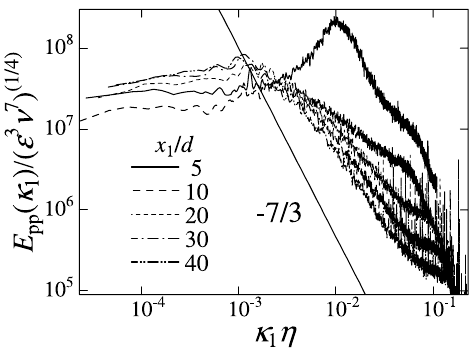
Fig. 16 Power spectra of fluctuating static pressure on the